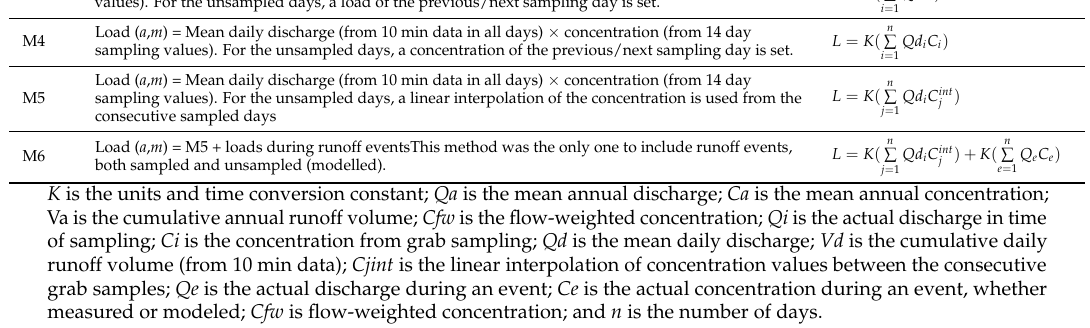
Figure 3. Using the semi-automated algorithm for the identification of REs; an example from the VP2 site.